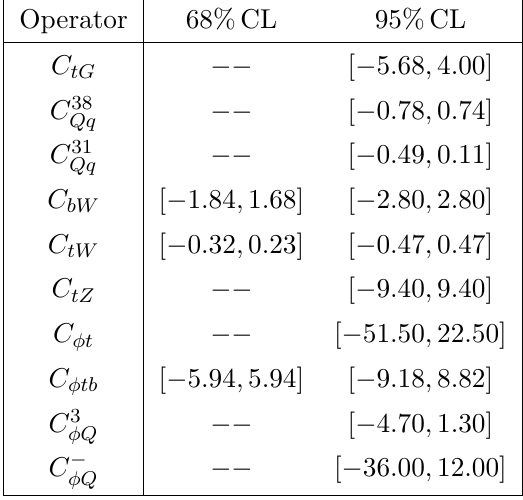
Table 7 . Bounds on the Wilson coe(cid:14)cients C i in units of (TeV = (cid:3)) 2 at 68% and 95% con(cid:12)dence level from our single top (cid:12)t, corresponding to (cid:12)gure 11.